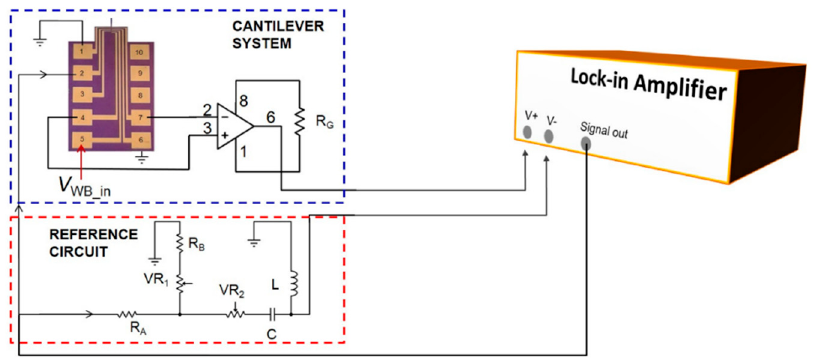
Figure 8. Setup of phase-characteristic optimization by reference signal subtraction.